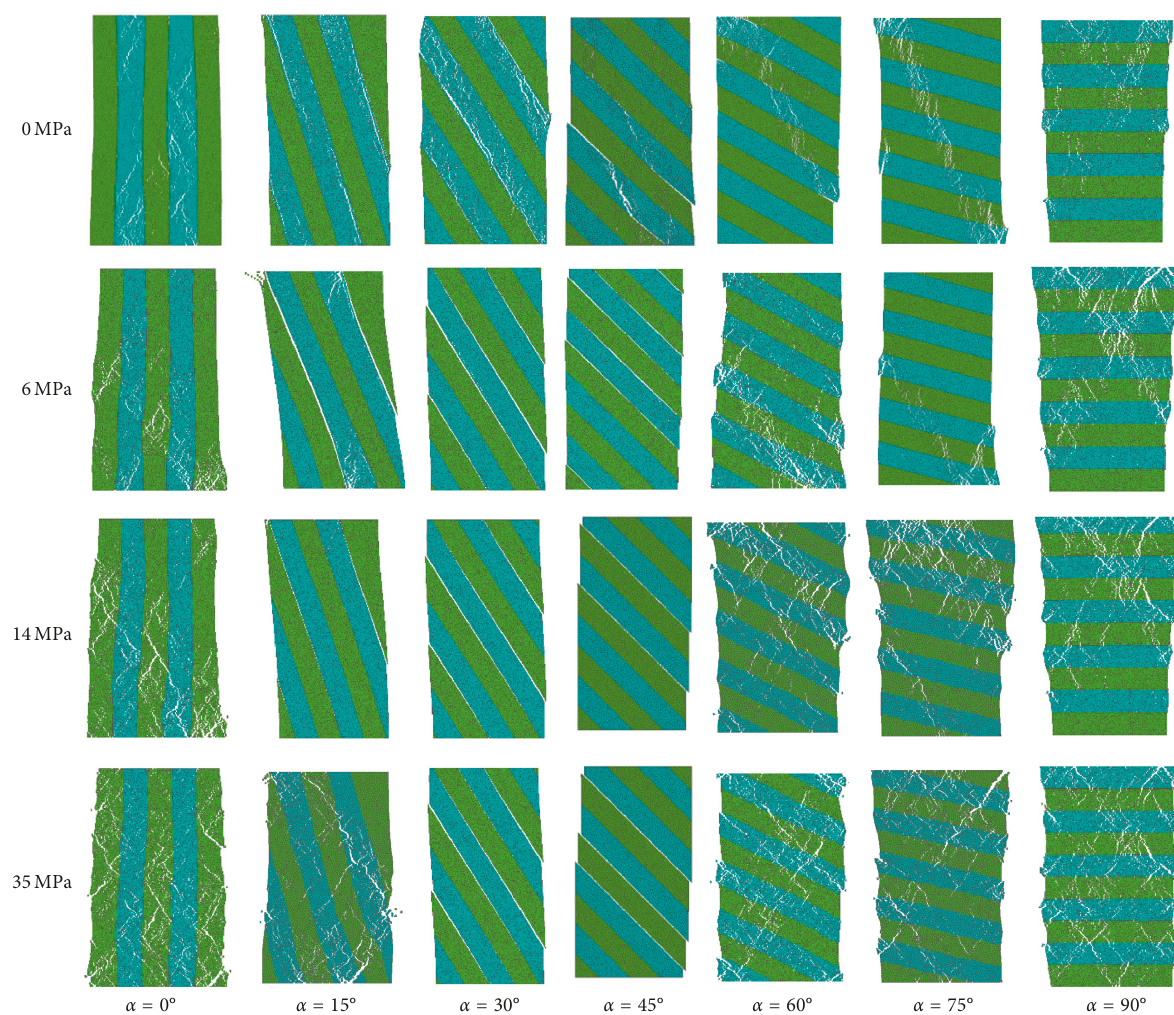
Figure 18: Failure modes of specimens with different orientations under compression with different confining